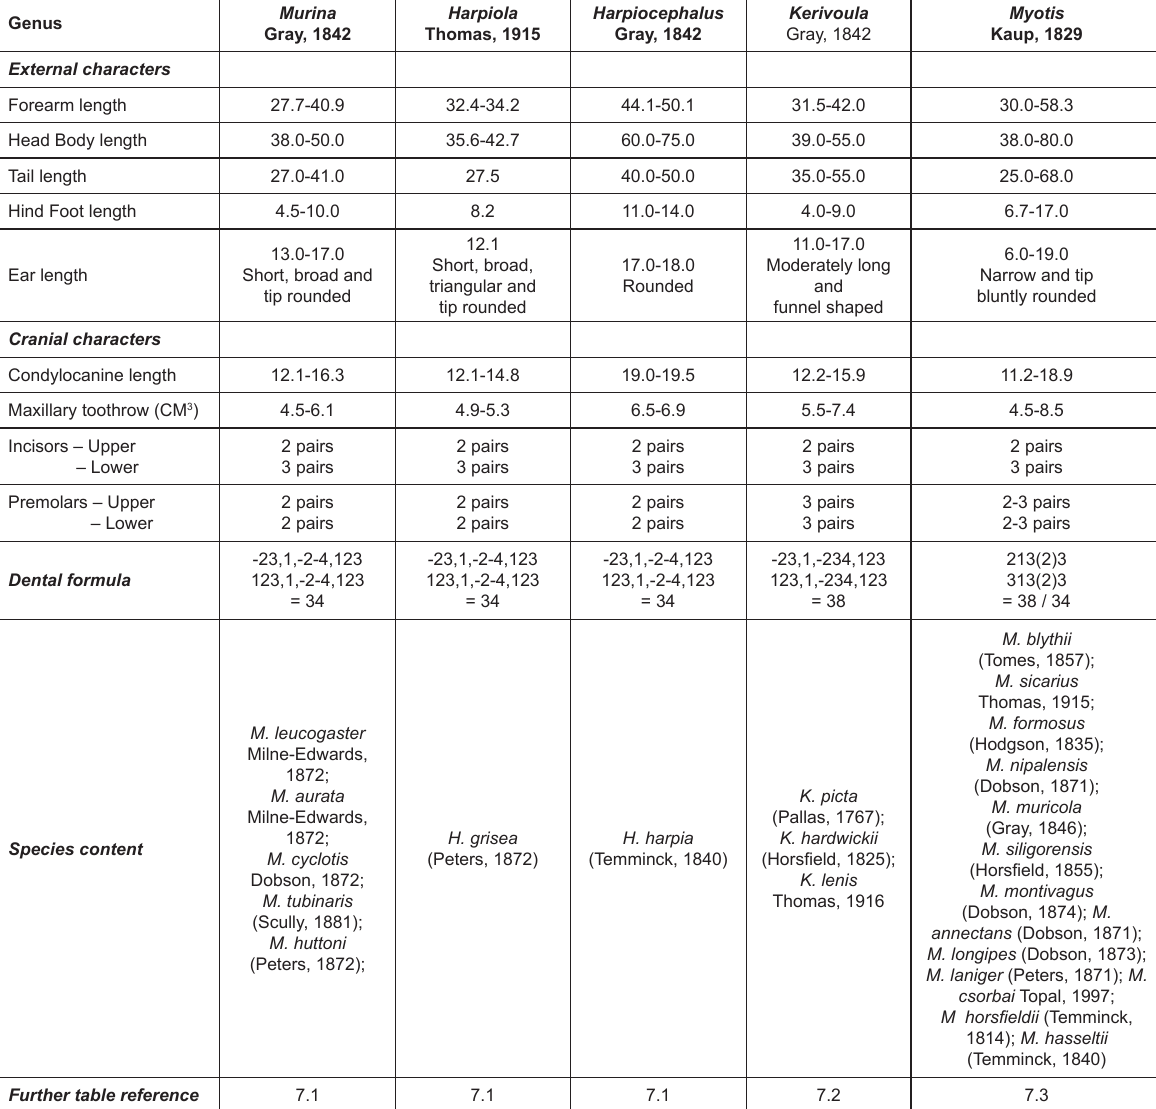
Table 7. Diagnostic morphological characters of the genera of the subfamilies Murininae, Kerivoulinae and Myotinae of family Vespertilionidae present in South